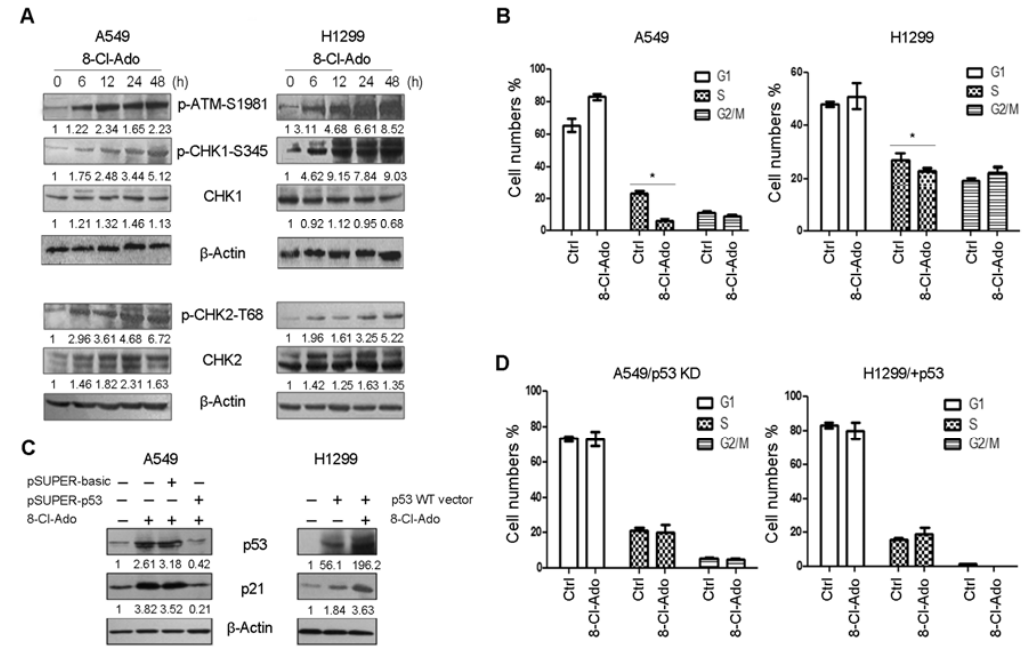
Figure 5. Signal pathways and cell-cycle progression in DDR (DNA damage response). ( A ) A549 and H1299 cells were exposed to 2 μ M 8-Cl-Ado for indicated hours, and Western blotting was performed for components of signal-transduction pathways. The relative levels of target proteins were normalized against β -Actin; ( B ) cell-cycle analysis. Cells were exposed to 2 μ M 8-Cl-Ado for 48 h. After harvested and fixed, cells were stained with propidium iodide (PI); PI signal was measured by FACScan. G1, G2/M and S populations in the cell-cycle were analyzed by computer programs. Data present ± SD ( n = 3). * p < 0.05; ( C ) Western blotting for p53 and p21 in p53-silenced A549 and p53-overexpressed H1299 cells. Cells were transiently transfected with pSUPER-basic (control), pSUPER-p53 (for silencing TP53), or p53-WT expression plasmid for 48 h and exposed to 8-Cl-Ado for additional 48 h, followed by Western blotting. The relative levels of target proteins were normalized against β -Actin; ( D ) G1 and G2/M and S subpopulations in p53-silenced A549 cells and p53-overexpressed H1299 cells.